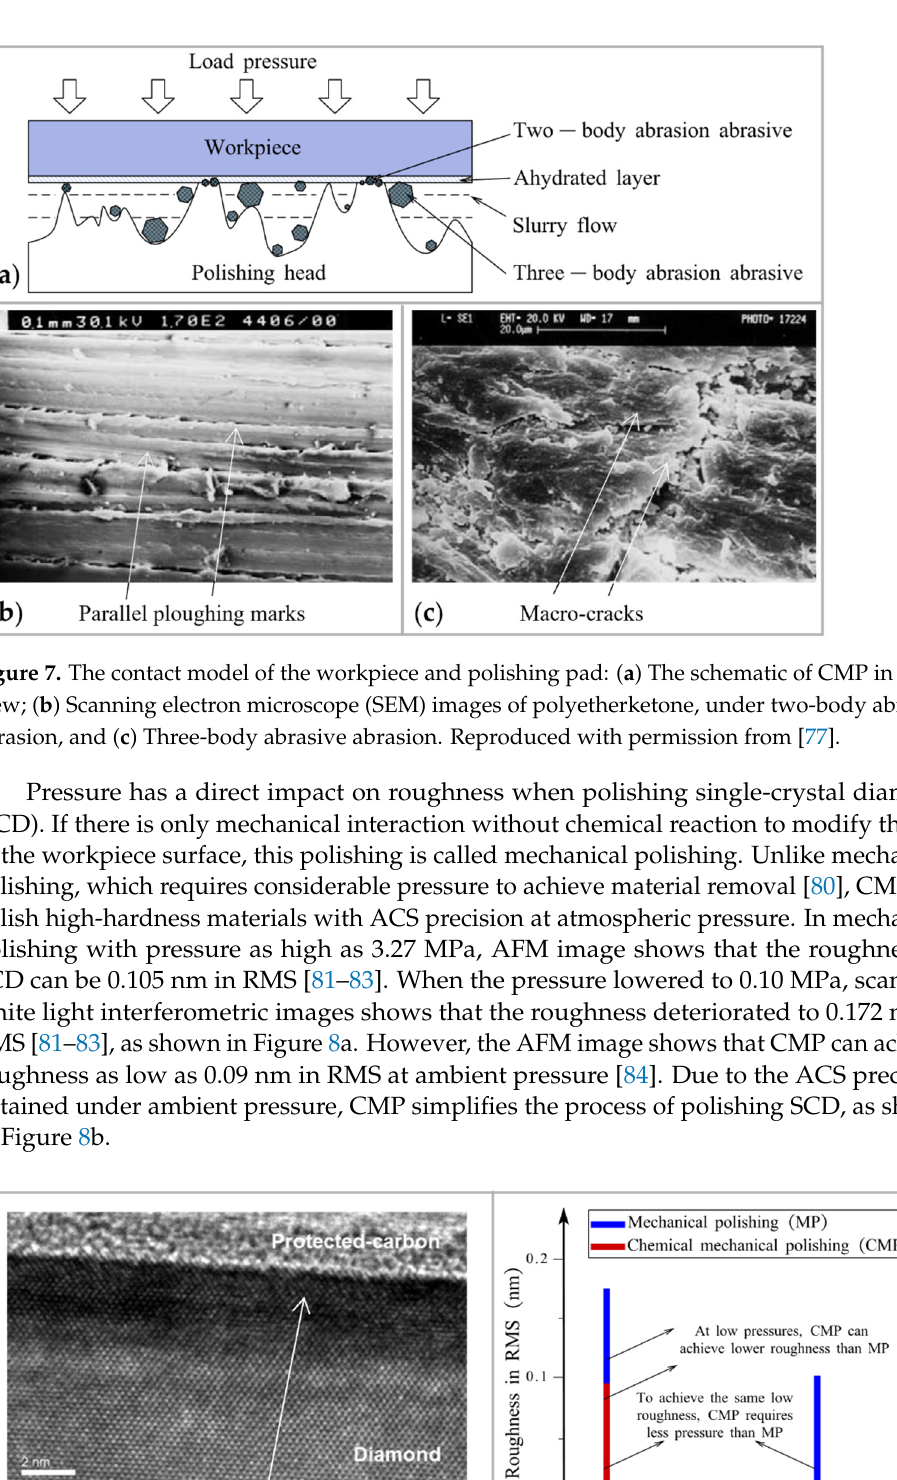
Table 1. The ultimate roughness achieved with CMP for different materials.